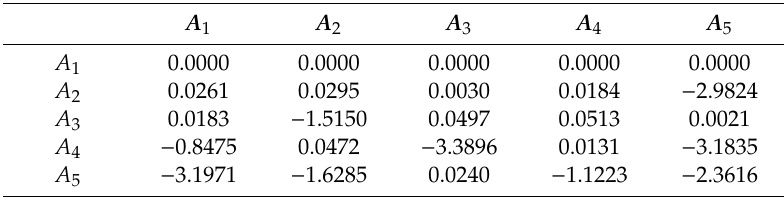
Table 15. Relative prospect dominance ϕ 1